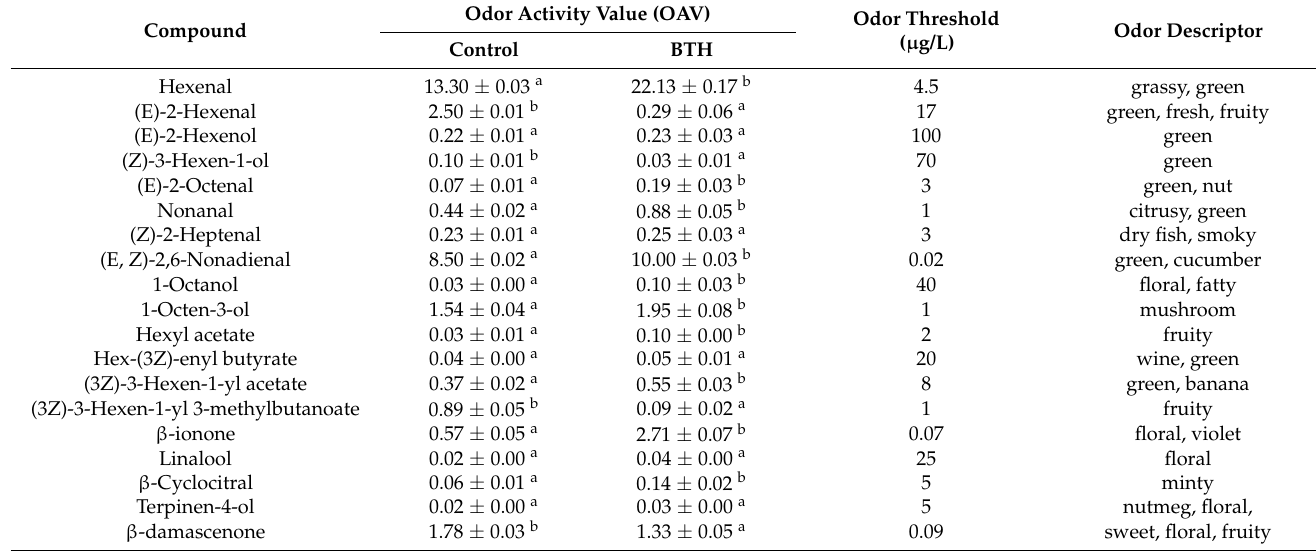
Table 1. Odor Activity Values (OAV ≥ 0.1) of untreated (control) and treated Cabernet Gernischt cv grapes at harvest